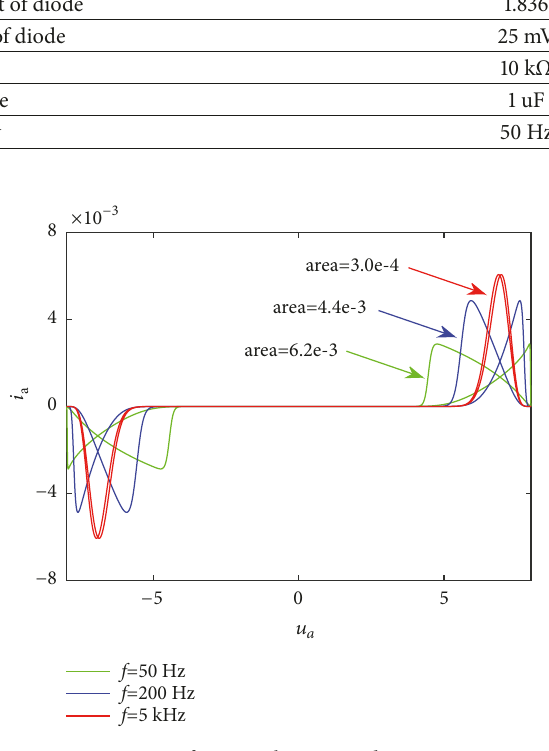
Figure 5: Curves of input voltage 𝑢 a and input current 𝑖 a